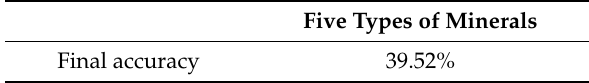
Table 3. Result of deep learning for RGB images for the learning